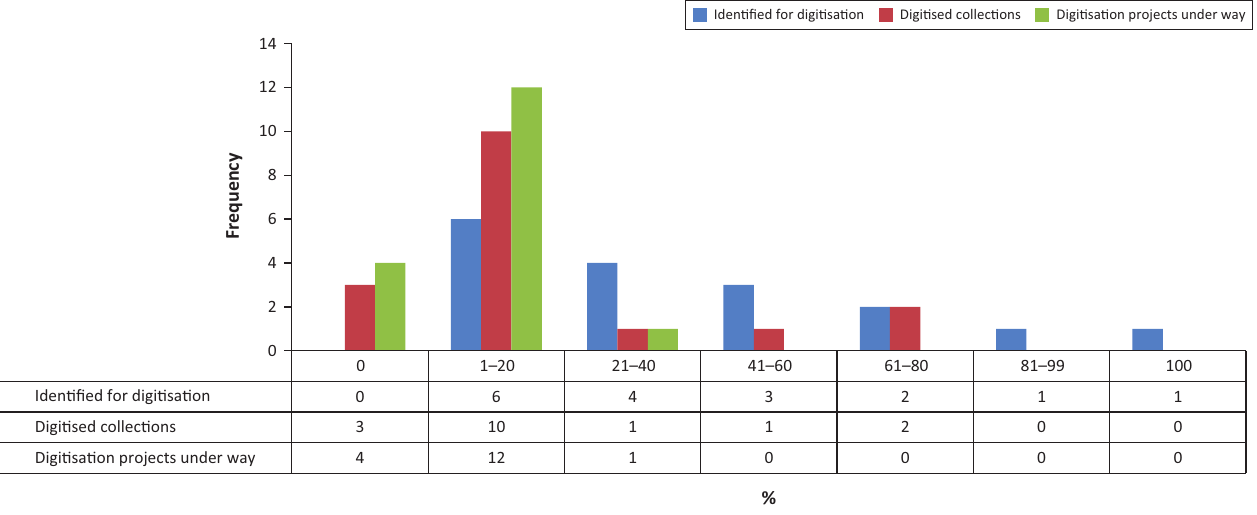
FIGURE 1: Summary of digitisation activity ( N =